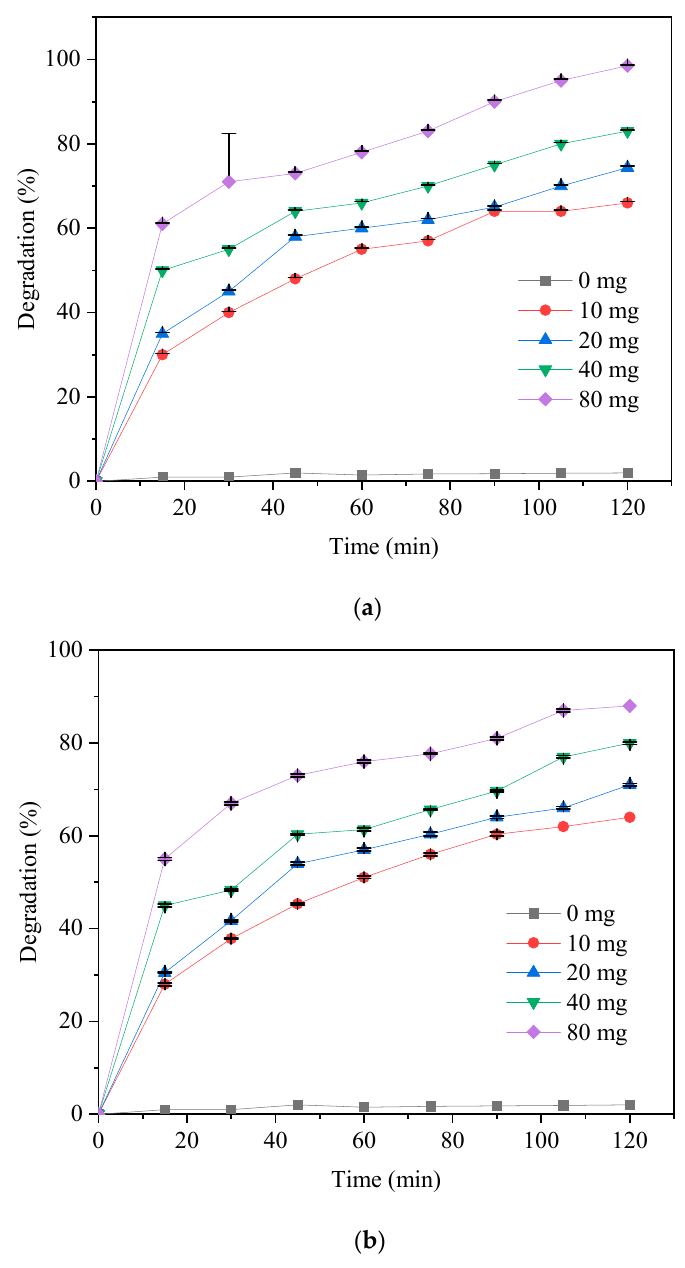
Figure 8. The effect of catalyst loading on the photoreduction of TC on ( a ) digenite and ( b ) covellite.